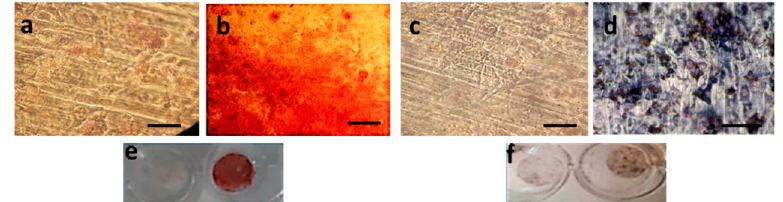
Figure 5. ( a ) MRC-5 cells after culturing on a non-modified PMMA-HEMA surface (control for alizarin red staining). ( b ) Alizarin red staining of the extracellular calcium deposits formed on the 21st day of osteogenesis. MRC-5 cells were reprogrammed and differentiated into osteoblasts by the immobilized 5 on PMMA-HEMA surfaces. ( c ) MRC-5 cells on untreated surface PMMA-HEMA (control for alkaline phosphatase assay). ( d ) Detection of alkaline phosphatase activity in cultures of MRC-5 cells on biofunctionalized PMMA-HEMA surfaces. The immobilized biotinylated aza-reversine 5 maintains its reprogramming ability. ( e ) Samples of the surfaces used for alizarin red staining (Left: Unstained MRC-5 cells on PMMA-HEMA surface used as control. Right: MRC-5 cells on biofunctionalized PMMA-HEMA surface stained positively for alizarin red). Scale bars: 0.5 μ m. ( f ) Samples of the surfaces used for alkaline phosphatase activity (Left: MRC-5 on control PMMA-HEMA surfaces that were not differentiated into osteoblasts. Right: Reprogrammed MRC-5 stained for alkaline phosphatase on biofunctionalized PMMA-HEMA surfaces).